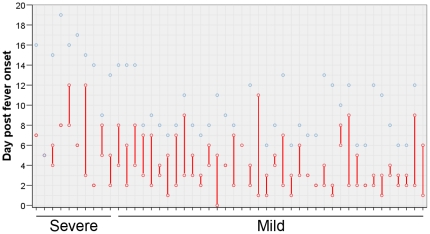
Detection of influenza virus RNA in respiratory specimens from patients with severe versus mild influenza.Nose and throat swabs were assessed for the presence of viral RNA as described in the methods. Red dots/lines indicate the first and last days from fever onset when viral RNA was detected, the first day being when the first sample was collected. Blue dots represent the last day that samples were tested.